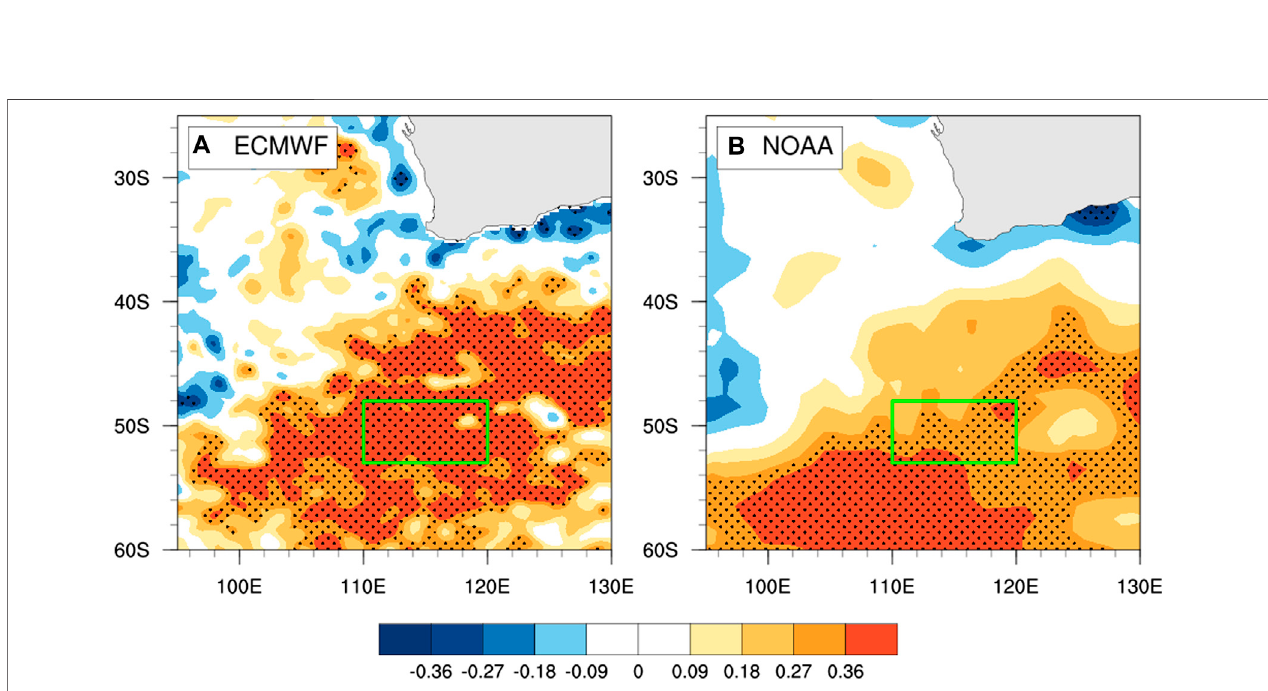
FIGURE 4 | Correlation maps between the March-April SST and the number of TC landfalls using (A) ECMWF (1979 – 2005) and (B) NOAA data (1982 – 2005). The dots indicate the areas where the correlation coef fi cients are signi fi cant at the 95% con fi dence level. The regions of SST SWA,34 are speci fi ed by the green rectangles.